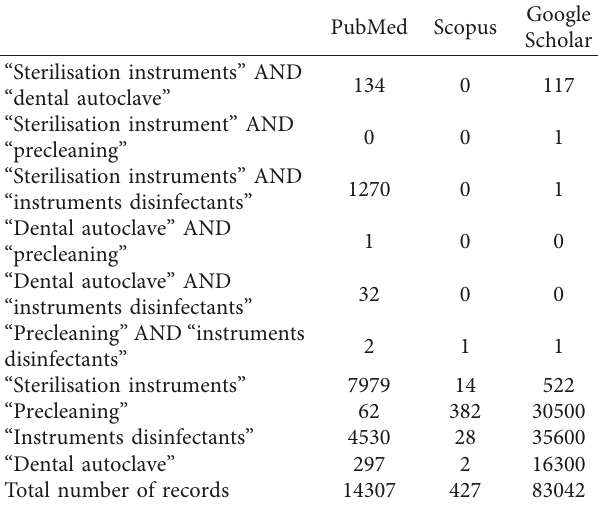
Table 1: A complete overview of the search methodology, illus- trating the keywords used, the Boolean operators adopted, and the number of records obtained for each online